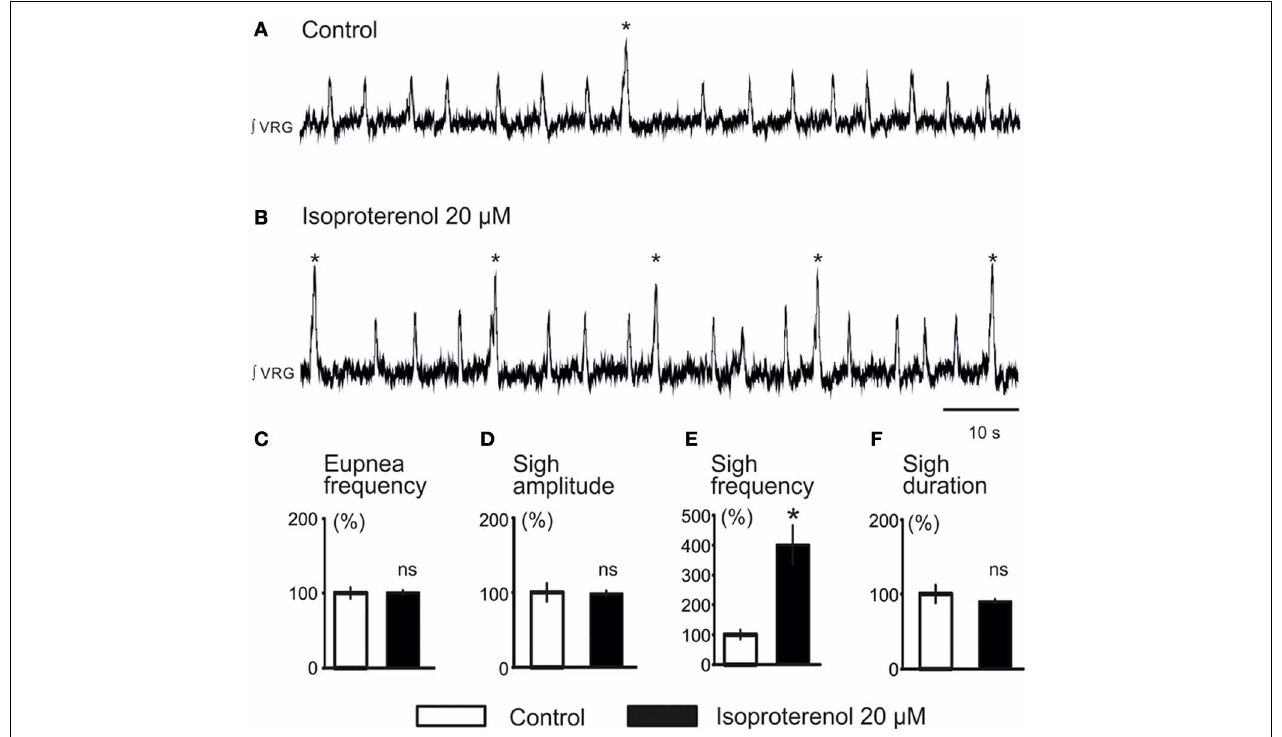
(cid:2) VRG activity activity. (C–F) Histograms show the effects of isoproterenol on sigh burst frequency (E) without affecting respiratory activity (C) , sigh burst amplitude (D), or the sigh burst area (F) ( ∗ p < 0 . 05, n = 10).